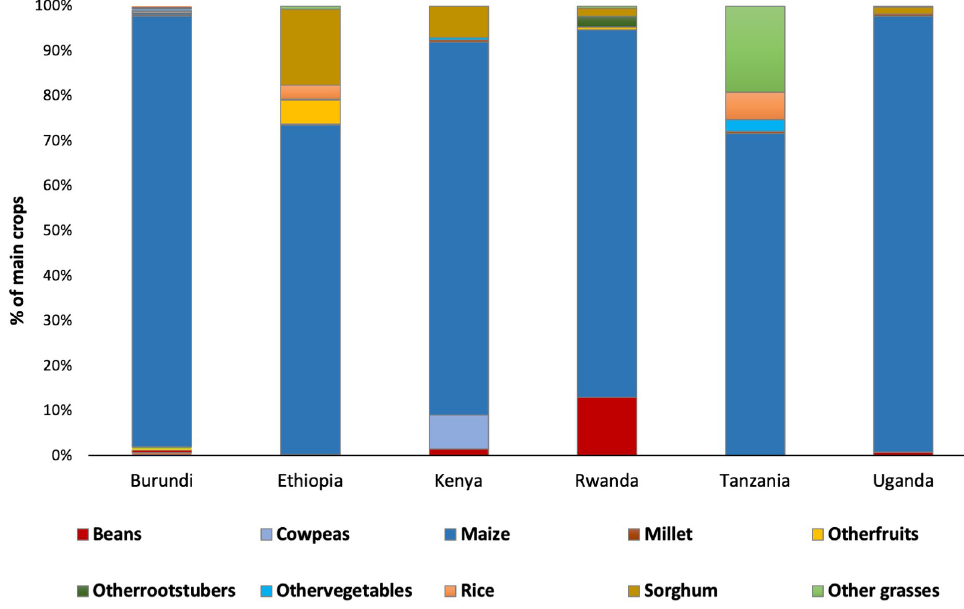
Fig 3. Country-wise proportion of the main crop in the study